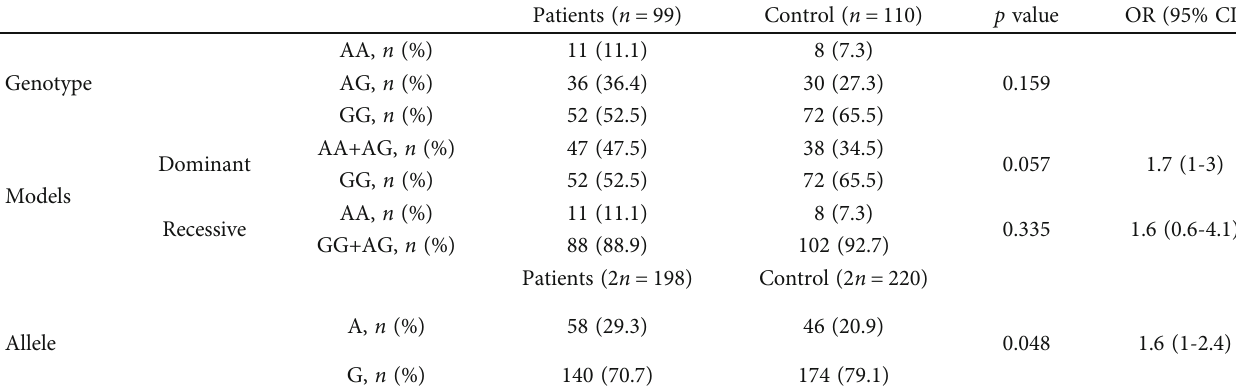
Table 1: Genotype and allele frequency of AIRE rs2075876 in the lupus patients and control groups.